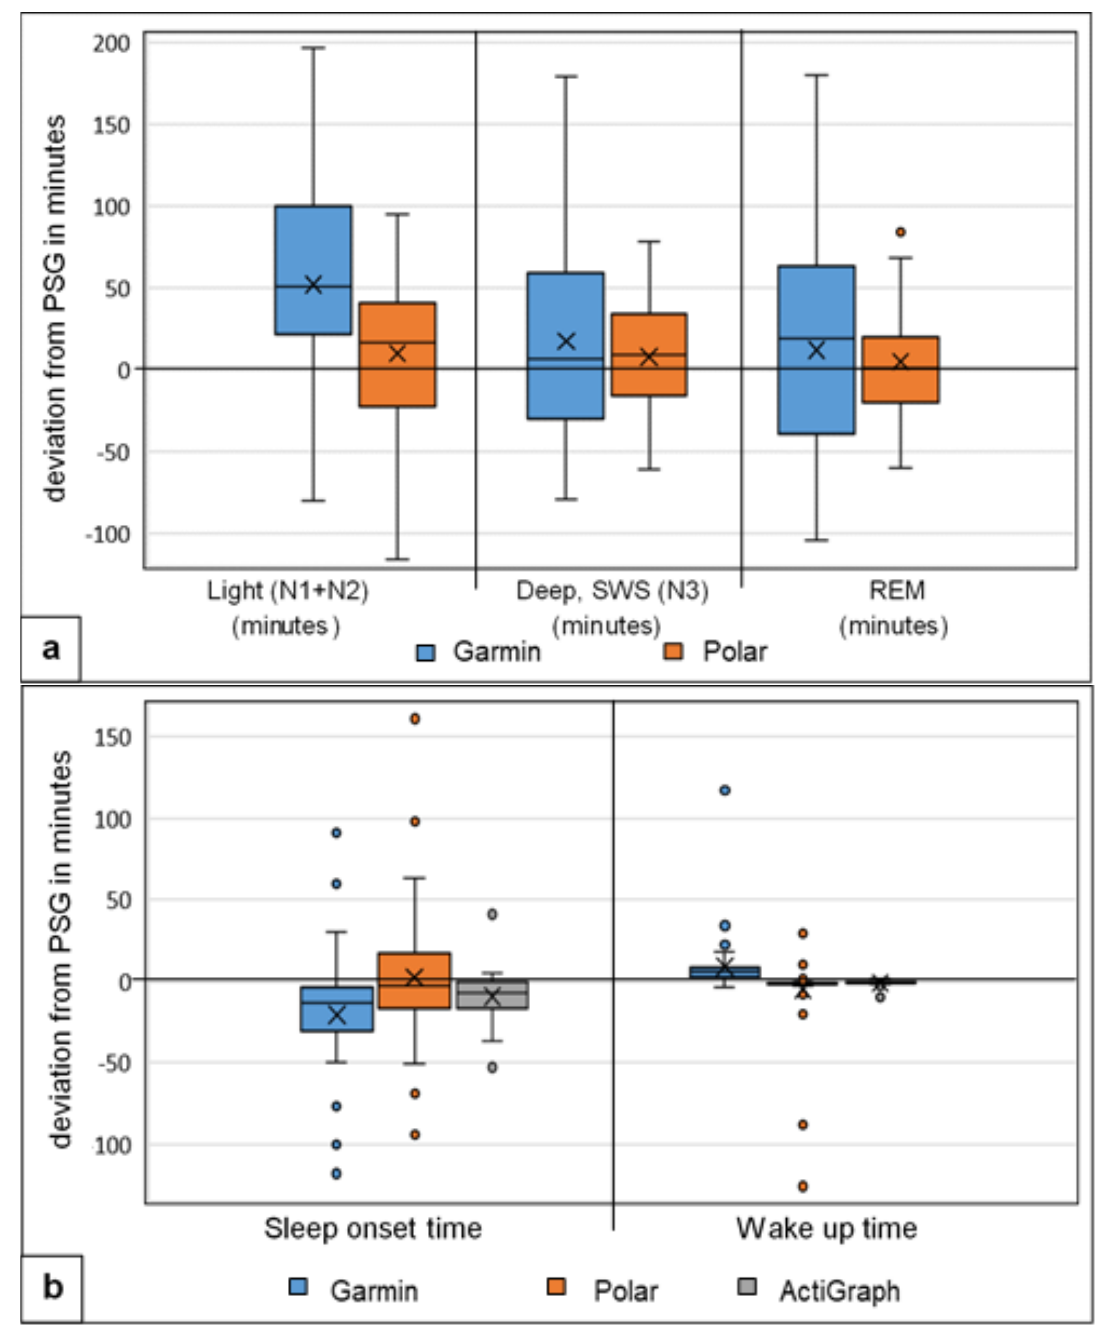
Figure 4. Boxplot analysis of calculated deviation ( a ) in sleep stages, Garmin and Polar against the gold standard PSG ( n = 49), Light = light sleep, Deep = slow-wave sleep (SWS), REM = rapid eye movement sleep (all expressed in minutes) and ( b ) in sleep onset time = start of sleep and wake-up time = end of sleep (deviation expressed in minutes), Garmin, Polar and accelerometer (ActiGraph GT9X) against the gold standard PSG ( n = 49); the x represents the mean value of deviation.